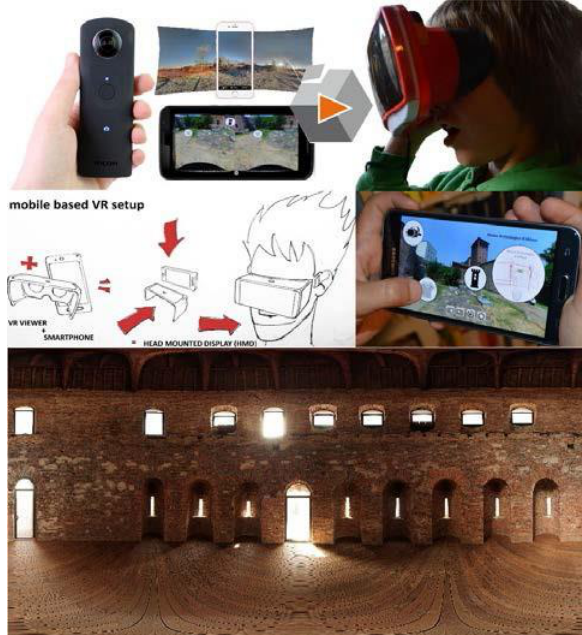
Figure 10 Explanation of the mobile based VR and 360° panoramic view of the polygonal tower navigable in VR The purpose was to realize a virtual tour of the area to display